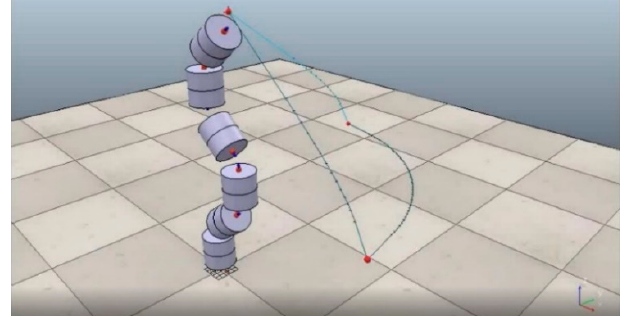
Figure 2. A model created in CoppeliaSim